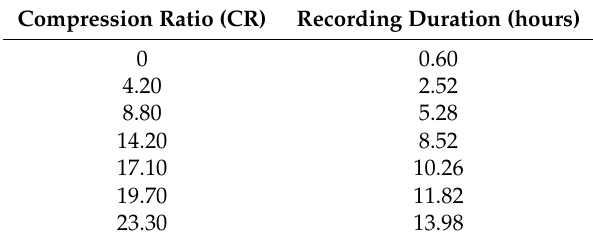
Table 4. EDA recording duration for a given compression ratio (CR) using 48 kB of memory